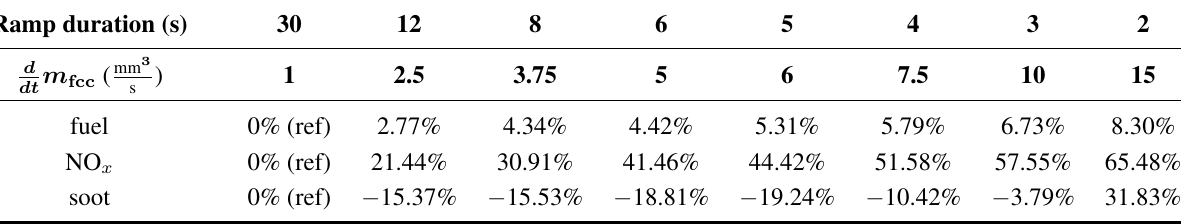
Table 2. Effect of increasing load gradients: fuel, NO engine power (normalized